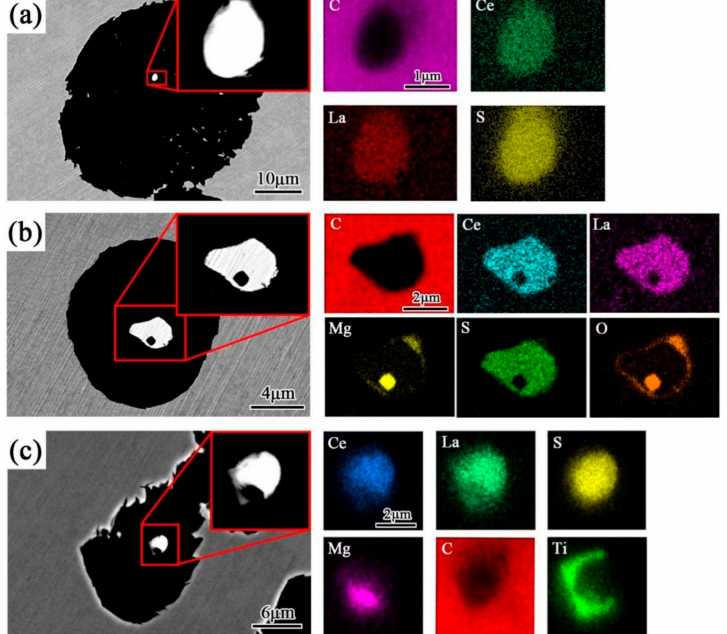
Figure 5. SEM/EDS analysis of graphite in CGI alloyed by RE: ( a ) heterogeneous core with RE 2 S 3 , ( b ) heterogeneous core with RE 2 S 3 and MgO, and ( c ) heterogeneous core with RE 2 S 3 , MgS, and carbide.